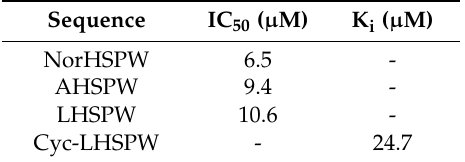
Table 3. IC 50 or K i values of inhibitors of Aminopeptidase